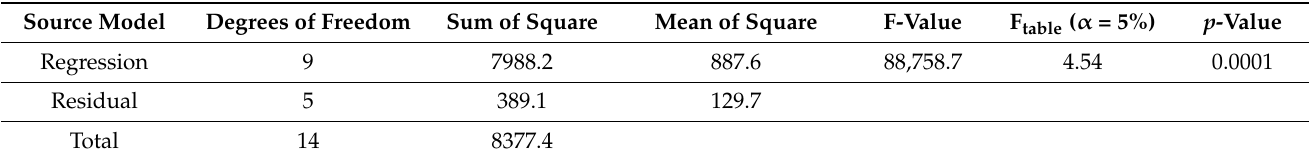
Table 7. Analysis of